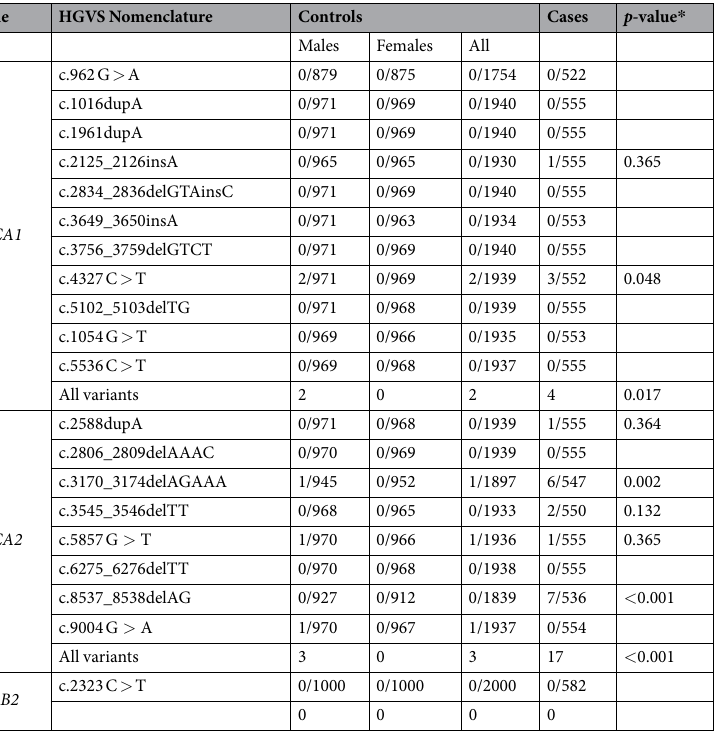
Table 2. Germline heterozygous variants identified in cases and controls. * The female controls and cases were compared using Fisher’s Exact